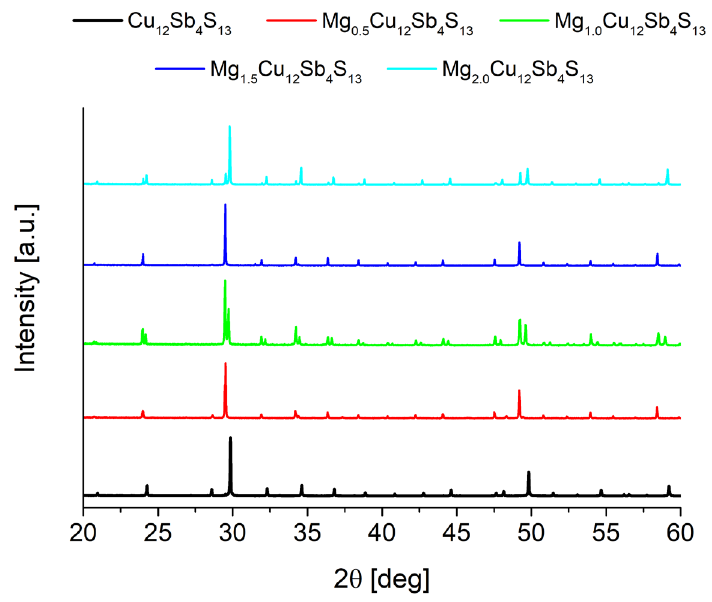
Figure 7. XRD diffraction patterns of Mg x Cu 12 Sb 4 S 13 specimens after synthesis.